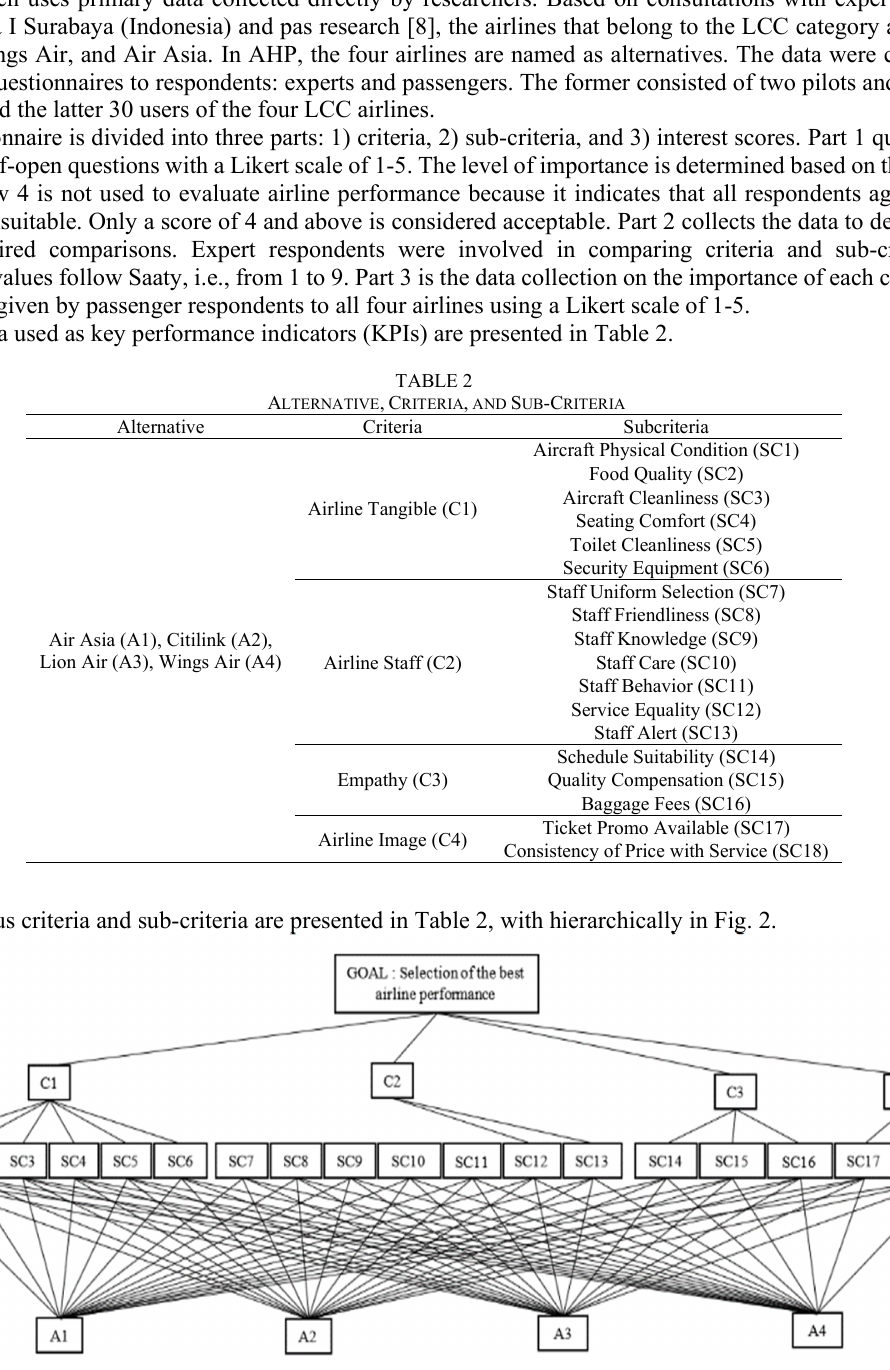
Fig. 2 Hierarchical structure of the selection of best airline